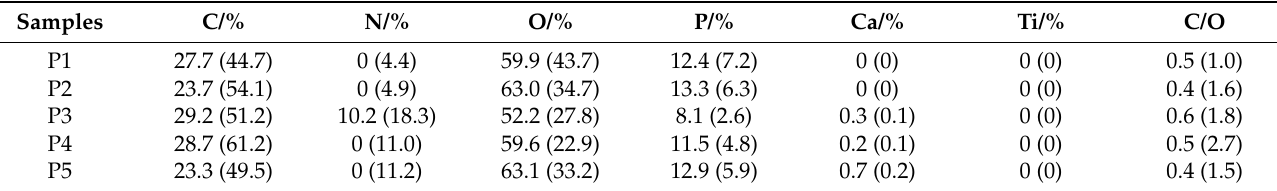
Table 7. EDS data of surface carbon layer and inner carbon layer.